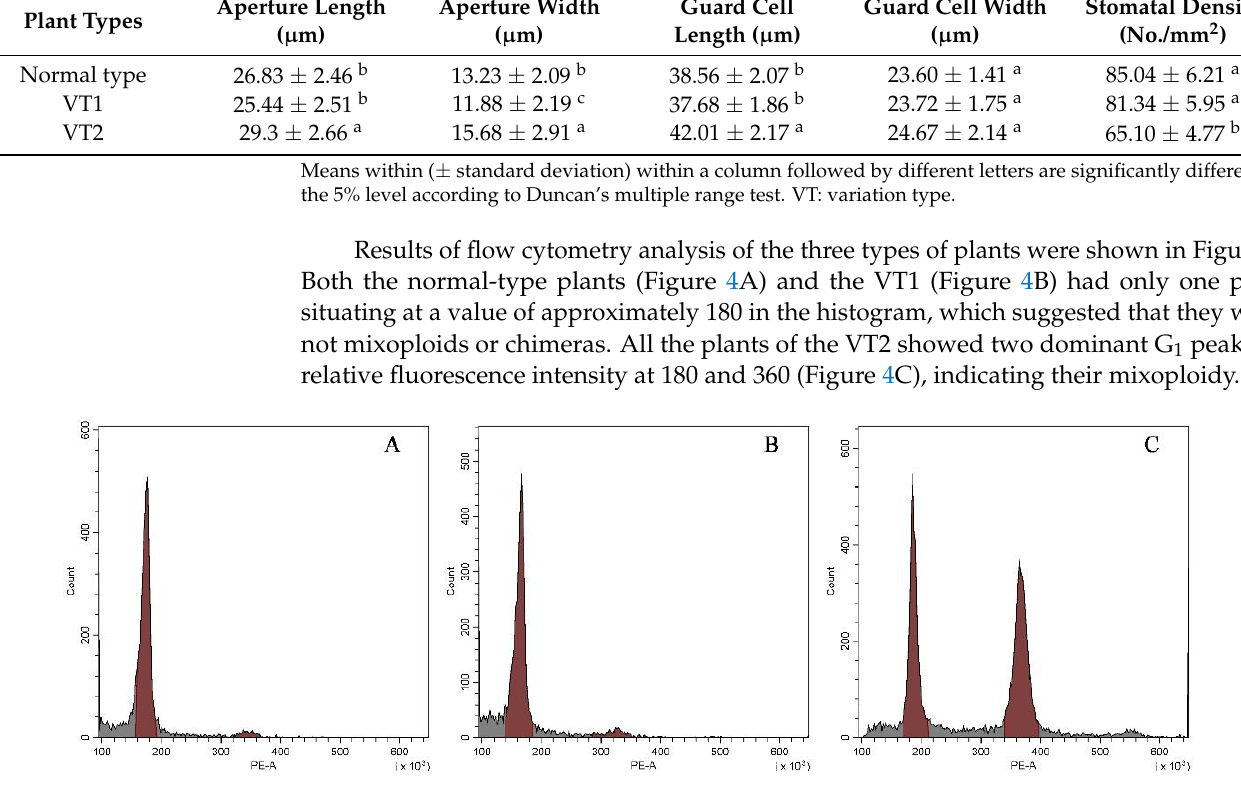
Table 5. Differences in stomatal parameters among the normal-type ginger and the two variation types at harvest.